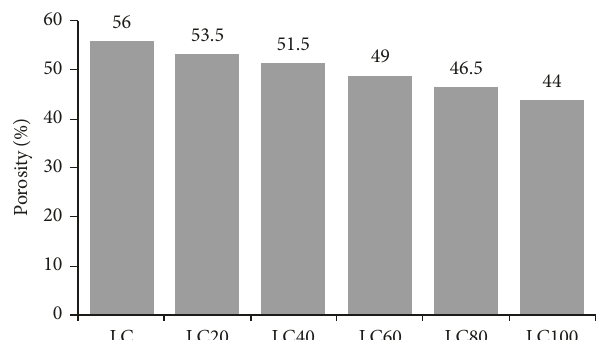
Figure 6: Effect of SWM dosage on the porosity of LC.